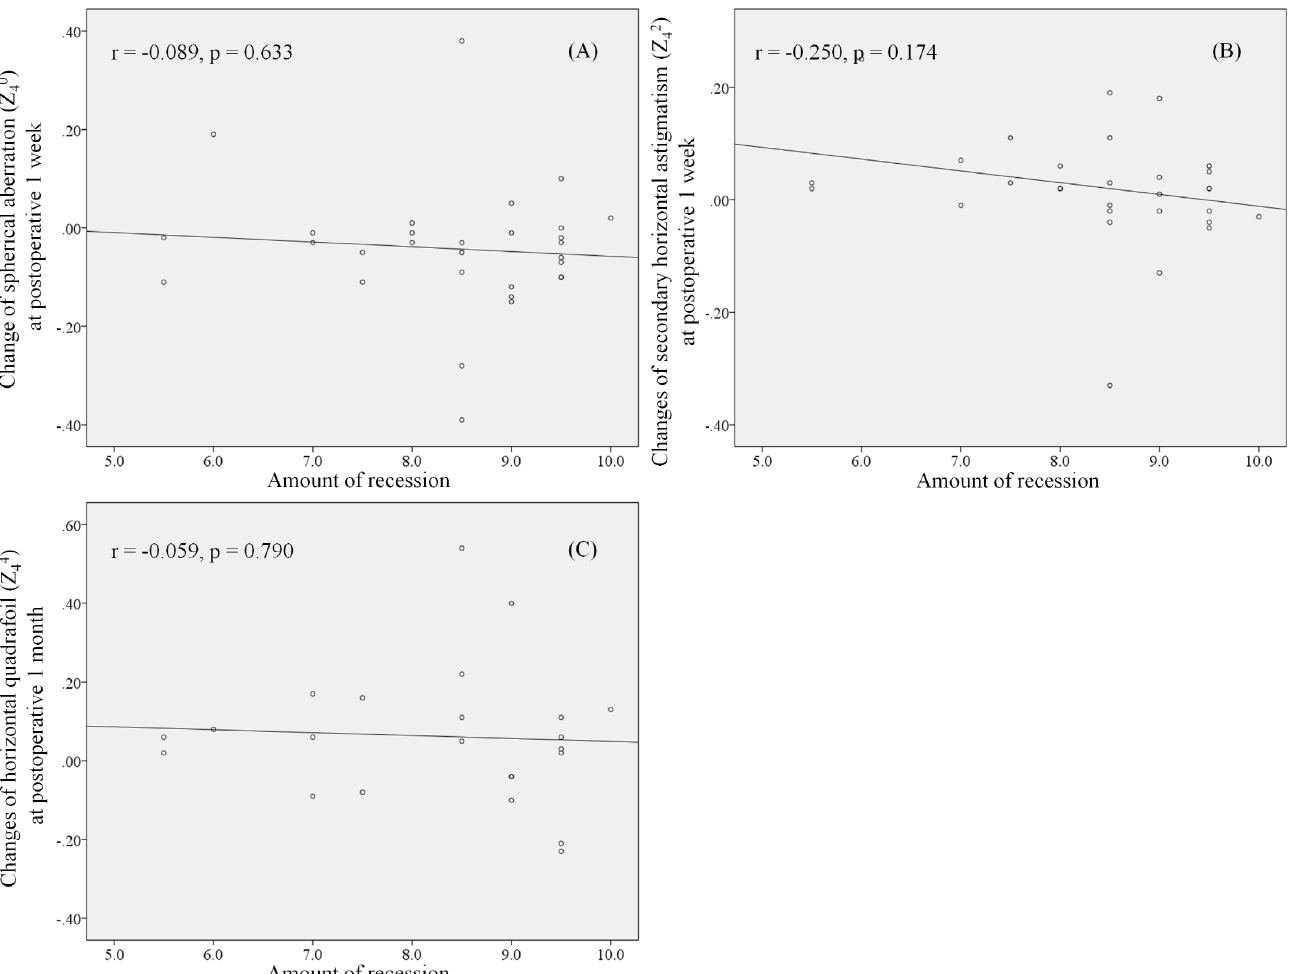
Fig 1. Correlation between recession amount and postoperative change of HOAs in group A (r = Pearson correlation coefficient). (A) Correlation between recession amount and change of spherical aberration (Z 40 ) at postoperative 1 week. (B) Correlation between recession amount and change of secondary horizontal astigmatism (Z 42 ) at postoperative 1 week. (C) Correlation between recession amount and change of horizontal quadrafoil (Z 44 ) at postoperative 1 month.